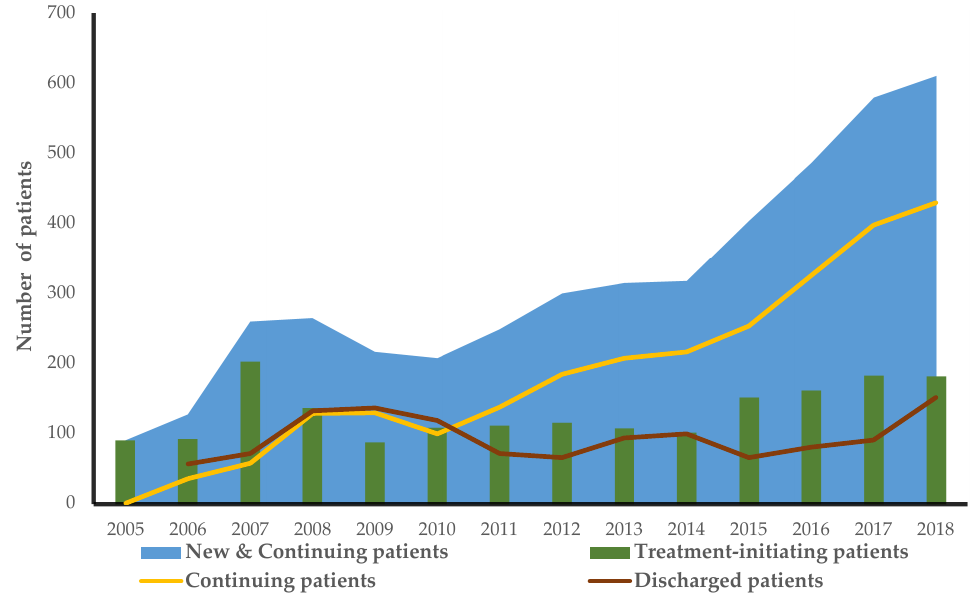
Figure 1. The annual number of new patients and those being treated the previous year, discharged patients, and patients in total. As a share of the total DR treatments at OUH, the proportion of laser treatments declined, and the proportion of IVIs increased over the 13 years of observation. As with laser treatment, vitreoretinal surgery showed a decreasing trend over time, with 3% of patients receiving vitreoretinal surgery in 2018 compared to 14% in 2005 (Figure A1 and A2). Fewer vitreoretinal surgery treatments were performed in the recent years compared to the years prior to 2010, with a number of patients being previously treated by laser and/or IVIs undergoing fewer vitreoretinal surgeries (Figure 2 and Figure A3). The same treatment patterns over time were observed according to the sex (results not shown).